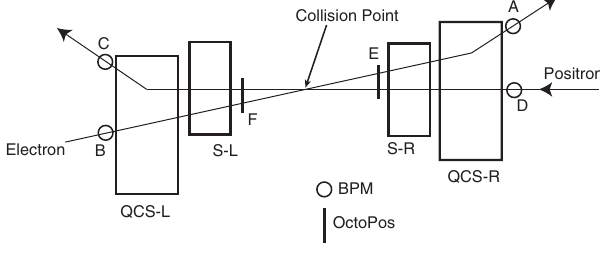
FIG. 1. Schematic view of BPM